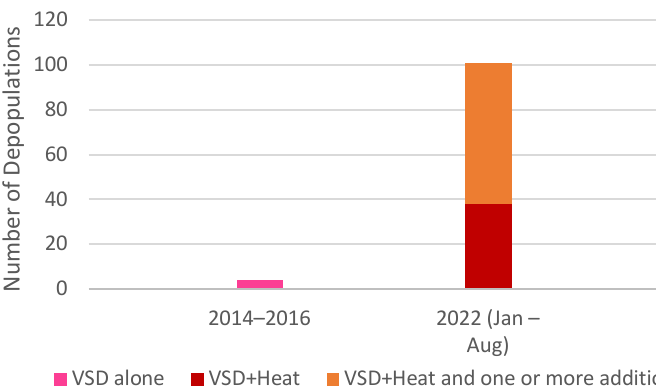
Figure 2. Number of commercial depopulations of poultry due to HPAI that involved the use of heatstroke-based methods.